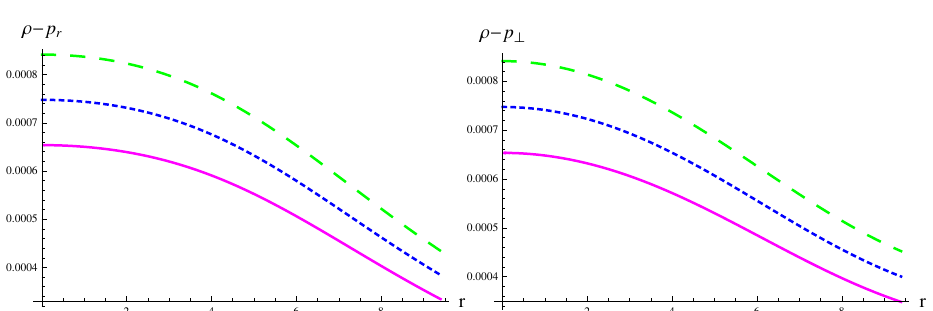
Figure 14. DEC for extended solution II for Υ =